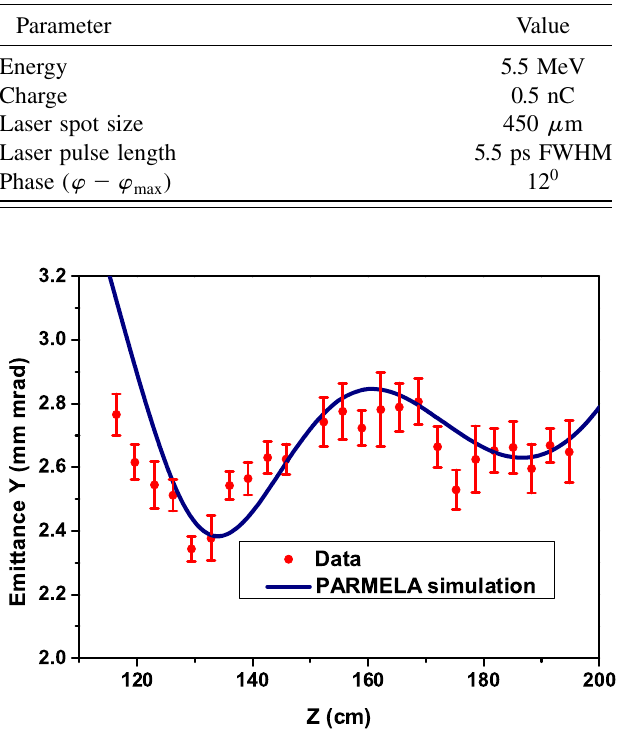
FIG. 20. (Color) Vertical emittance measurement showing a double minimum oscillation. A PARMELA simulation is also shown on the same plot for